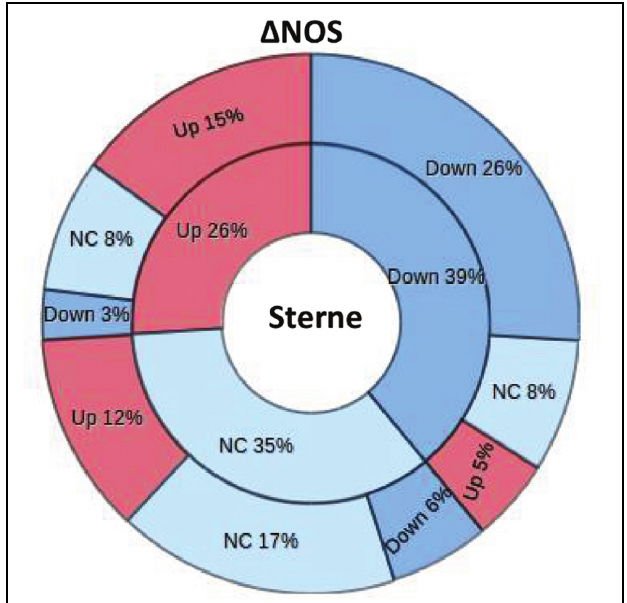
FIGURE 6 | The (cid:2) NOS infection leads to global changes in the lymph proteome relative to Sterme one. The segments of pie chart show the number of proteins from the total list of 581 proteins identified by MS as upregulated, downregulated, or unchanged during infection relative to uninfected mice. The inner circle corresponds to the Sterne-infected mice. The outer circle demonstrates changes of this pattern observed in (cid:2) NOS-infected